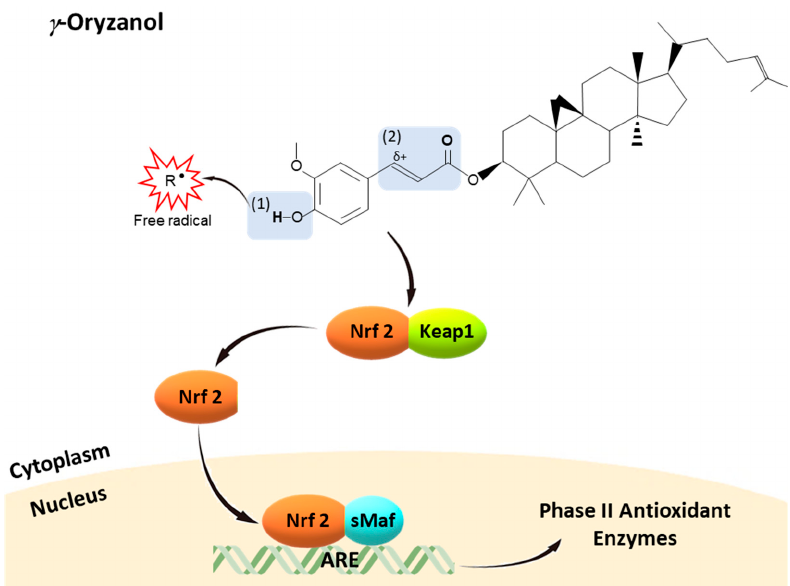
Figure 3. Antioxidants ( γ -oryzanol) in rice and structure-activity relationship. (1) The